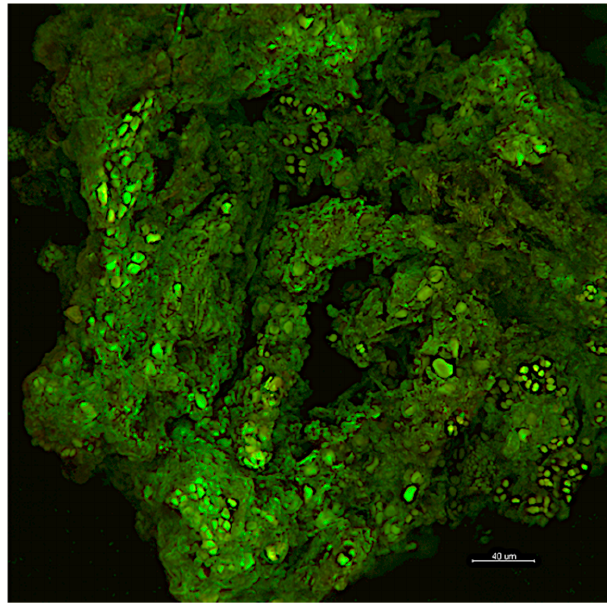
Figure 1. Confocal laser scanning imaging of biofilm growing on a Candoglia marble after a chemical cleaning (5% benzalkonium chloride followed by hydrogen peroxide) combined with a mechanical treatment (mechanical brushing and wet brushing) as previously reported by Villa et al. [12]. The green signal corresponding to Syto9 stain, which binds to DNA, appeared to be spread across the mineral surface. This result indicated the presence of intracellular material on the marble, which may suggest that dead cells were not completely removed after the cleaning treatment. The scale bar is 40 µm.